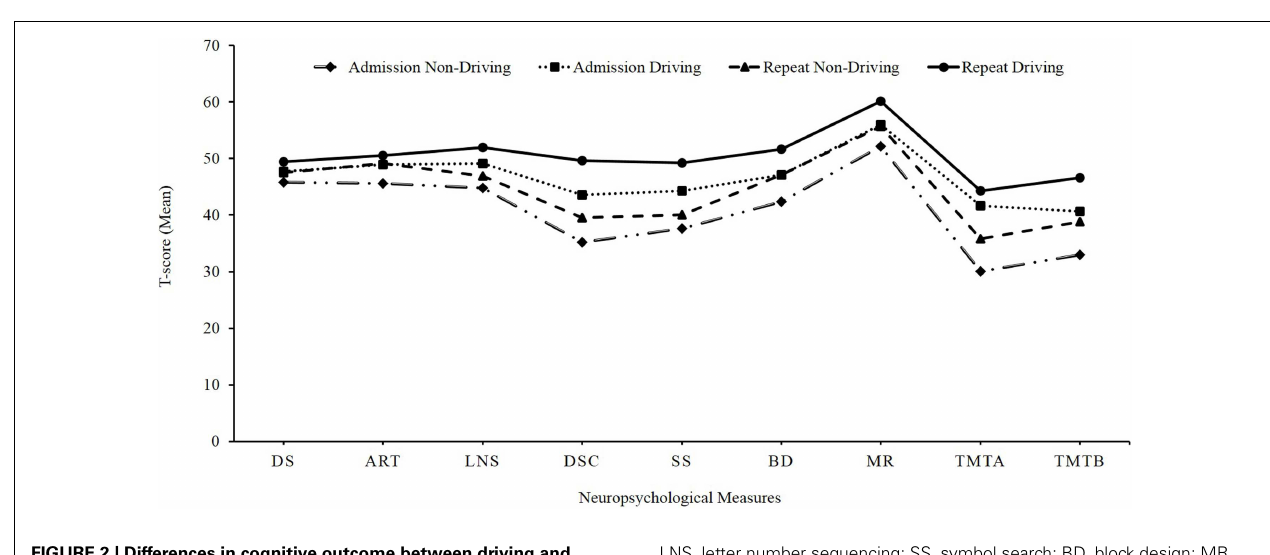
FIGURE 2 | Differences in cognitive outcome between driving and non-driving groups: mean t -scores of neuropsychological measures at admission and repeat evaluations . DS, digit span; ART, arithmetic;